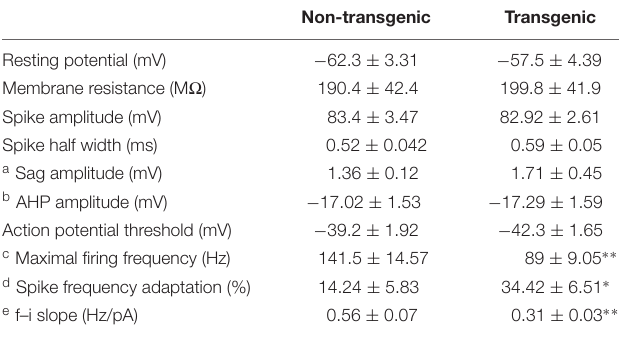
TABLE 1 | Membrane and firing properties of PV interneurons in J20-PV-Cre mice.